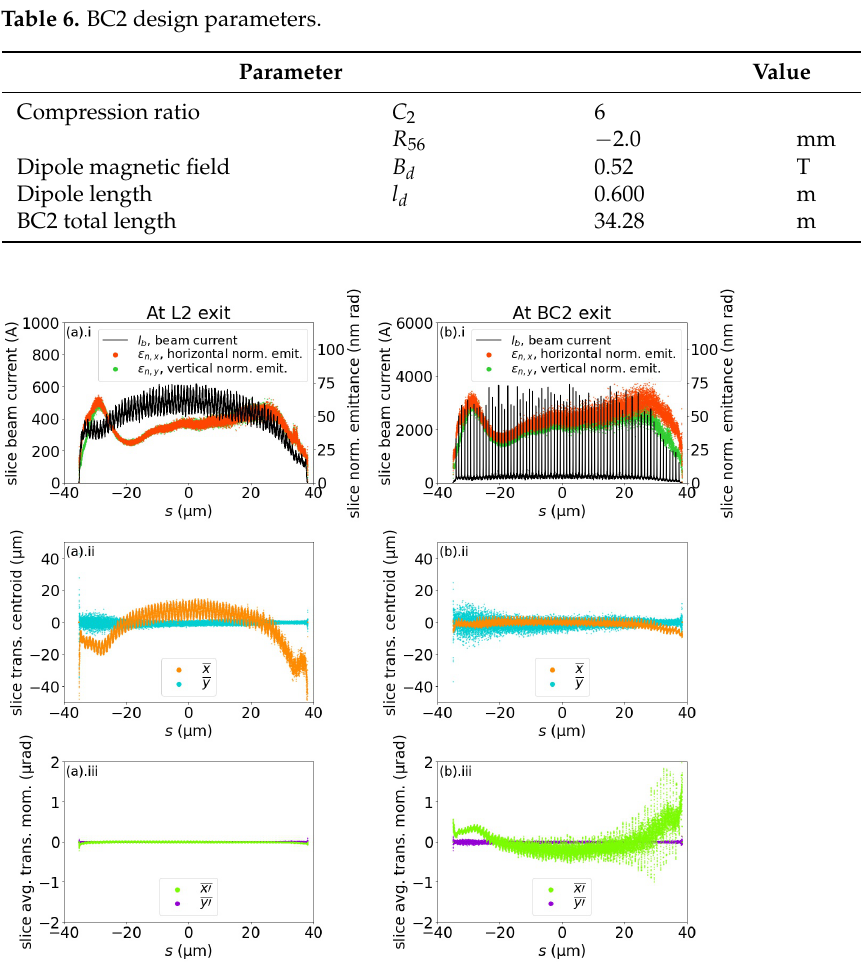
Figure 9. Performance of BC2 in lattice 1, where the electron beam had previously been compressed by BC1 of a conventional C-chicane configuration. The electron beam is divided into 20,000 slices at ( a ) L2 exit and ( b ) BC2 exit. ( a ). i and ( b ). i show the normalized emittances and the currents of each slice along the beam; ( a ). ii and ( b ). ii show the distributions of the transverse centroids; and ( a ). iii and ( b ). iii the distributions of the average transverse momentum